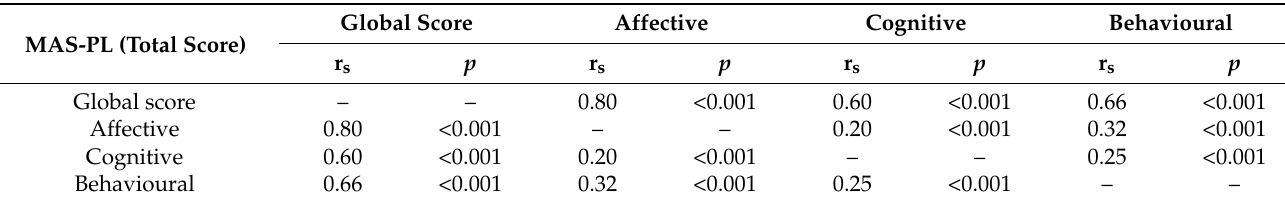
Table 7. Assumption of Spearman’s correlation analysis MAS-PL scores (total score, affective, cognitive and behavioural subscales; N = 625).